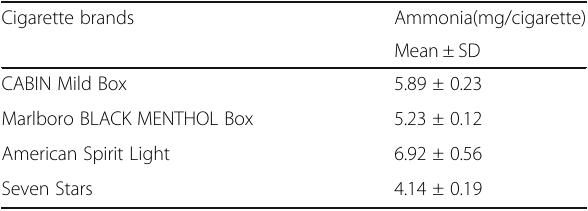
Table 3 Ammonia levels in sidestream smoke of four